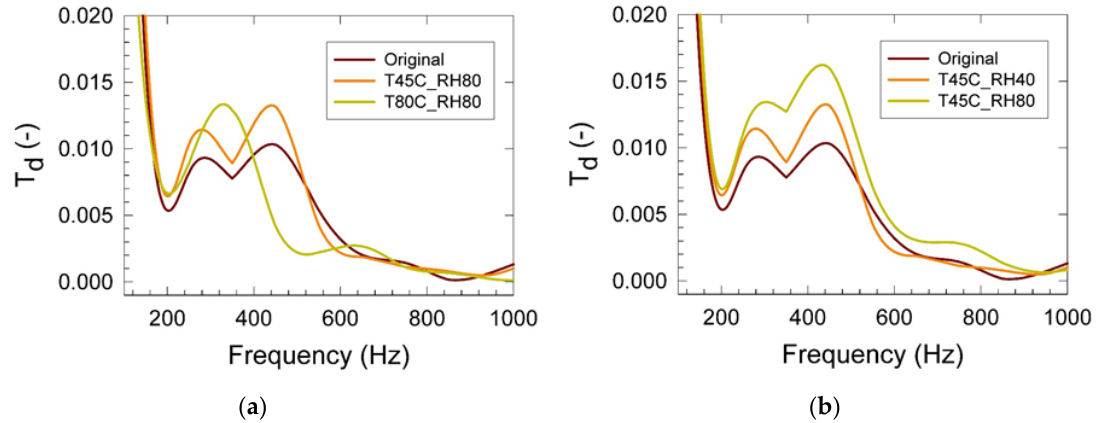
Figure 3. Displacement transmissibility vs. frequency as obtained from the vibration damping measurements of the studied PU materials after 300 h conditioning: ( a ) Effect of the conditioning temperature at 80% RH; ( b ) Effect of the conditioning relative humidity at 45 °C. Inset: T — temperature (°C), RH — relative humidity (%), Original — non-conditioned sample.